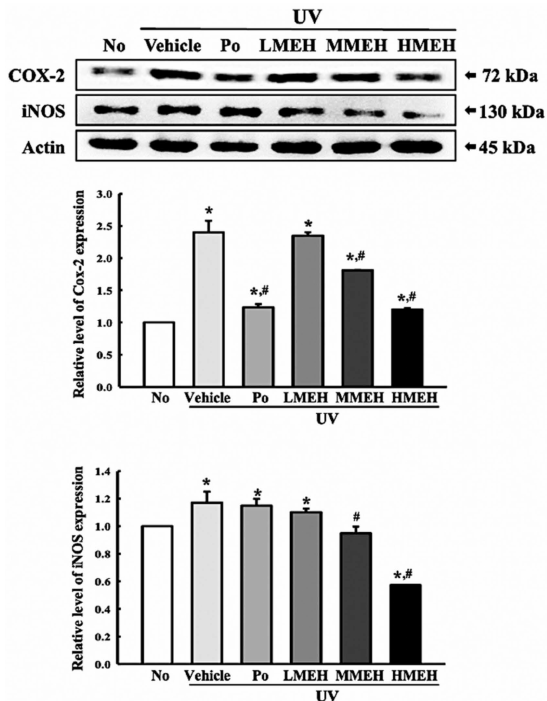
Figure 10. Expression of COX-2 and iNOS proteins in normal human dermal fibroblasts. Three dishes per group were used to prepare the cell lysates. Western blot was performed in triplicate. This experiment was performed for three times and results are the average of all experiments. The data are reported as the means ± SD of triplicate determinations. *, p < 0.05 compared to the untreated group. #, p < 0.05 compared to the UV + Vehicle. Abbreviations: COX-2, Cyclooxygenase-2; iNOS, Inducible nitric oxide synthase; Po, Positive control; MEH, Methanol extracts of Hygrophila erecta (Brum. F.) Hochr.